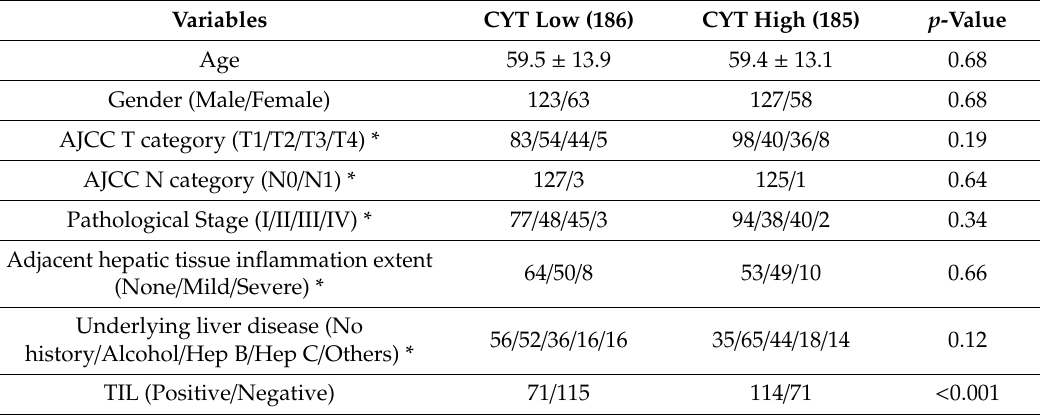
Table 1. Clinical demographics of TCGA